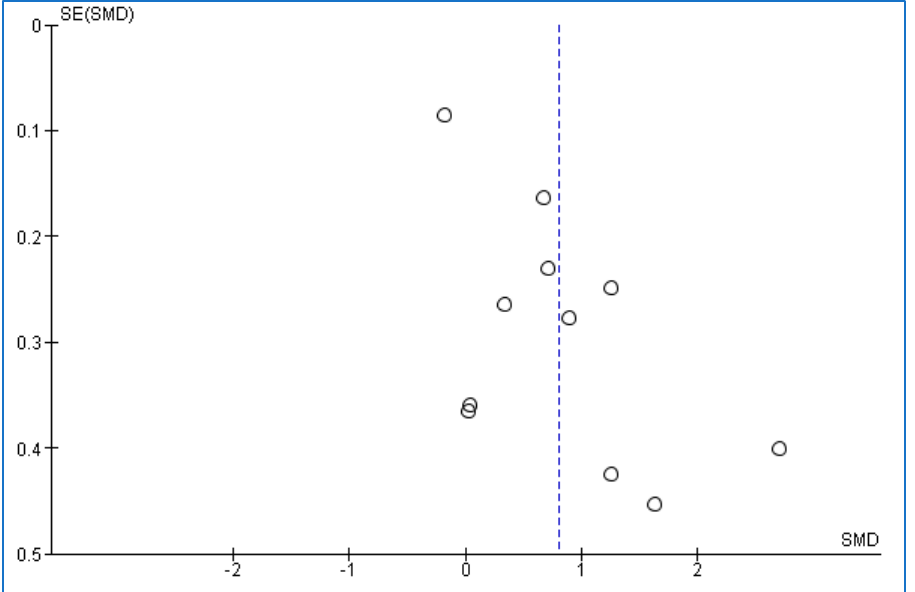
8 of 13 Table 3. Meta-regression analysis in adults with obstructive sleep apnea compared to controls. Variable